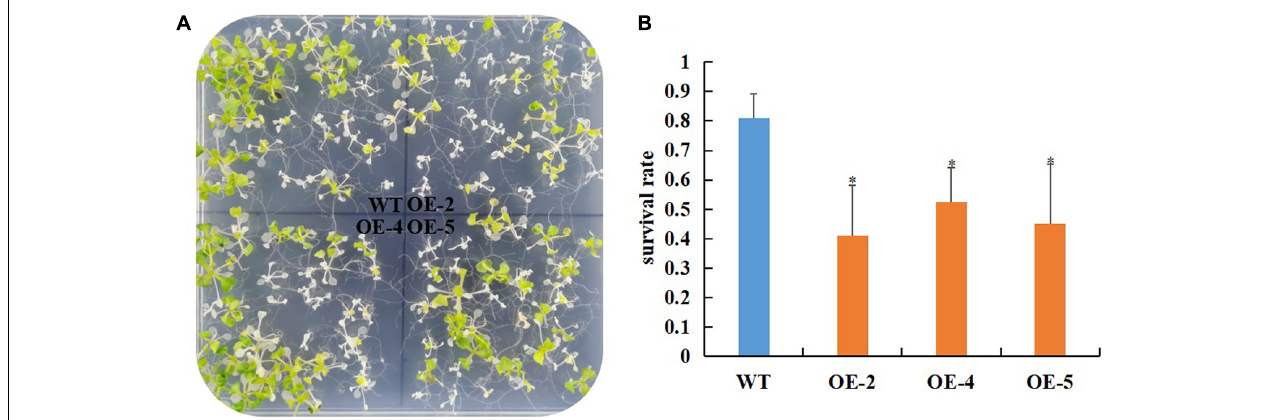
FIGURE 6 | Overexpression of RcGPX4 reduced freezing tolerance in transgenic plants. Freezing phenotype (A) and survival rate (B) of RcGPX4 overexpressing transgenic plants. Fourteen-day-old seedlings grown 1/2 MS at 22 ◦ C were pre-treated at 4 ◦ C for 3 days, subjected to freezing stress at –10 ◦ C for 5 h, and then recovered at 22 ◦ C for 5 days before counting survival rate. Data represent the mean ± SD of three independent biological replicates ( n = 42 seedlings for each replicate). Asterisks indicate a significant difference between wild type and overexpressed lines ( ∗ P < 0.05, student’s t -test). WT: wild-type; OE-2, OE-4, and OE-5: three T 3 homozygous transgenic